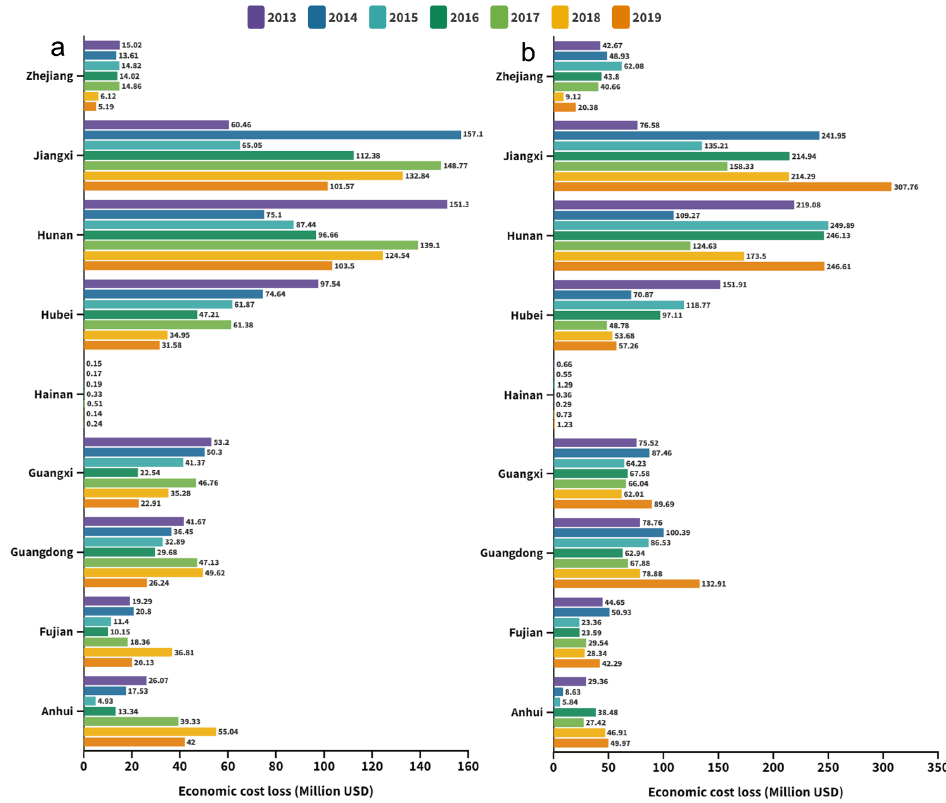
Figure 6. Regional statistics on the economic cost loss by ozone exposure from 2013 to 2019. ( a ) Double ‐ early rice period and ( b ) double ‐ late rice period.